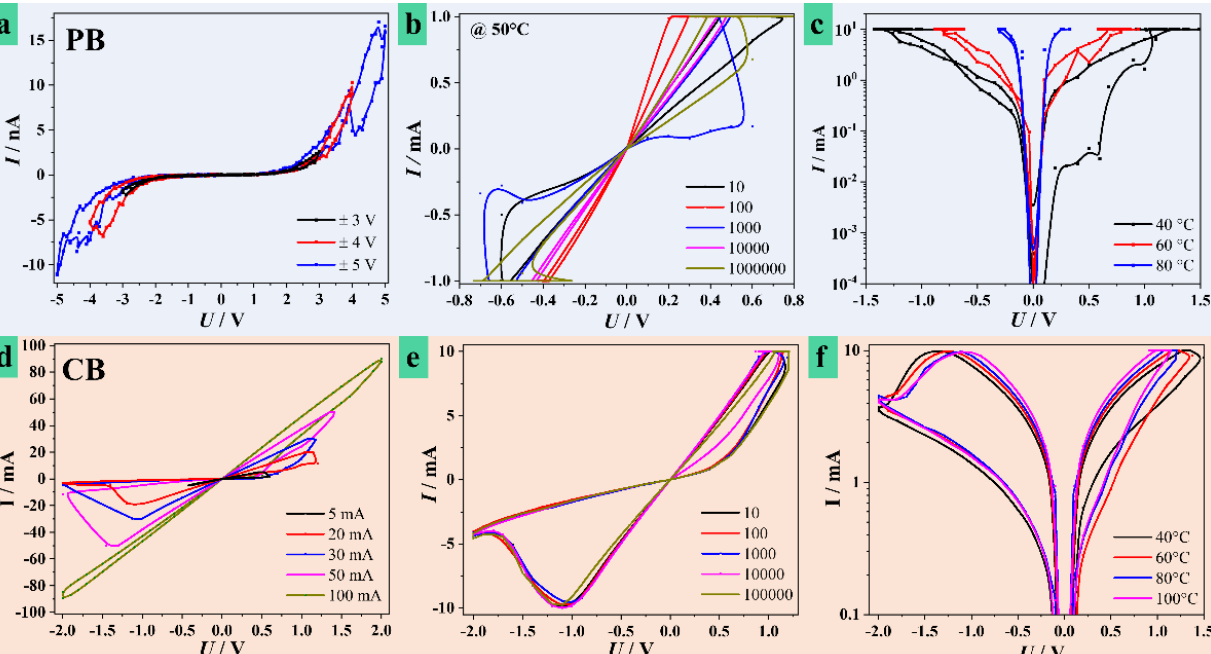
Figure 5. Memristor switching curves with details of endurance testing for increasing cycles numbers and device I-V performance at different temperatures for devices grown in PB ( a – c ) and CB ( d – f ) electrolytes.